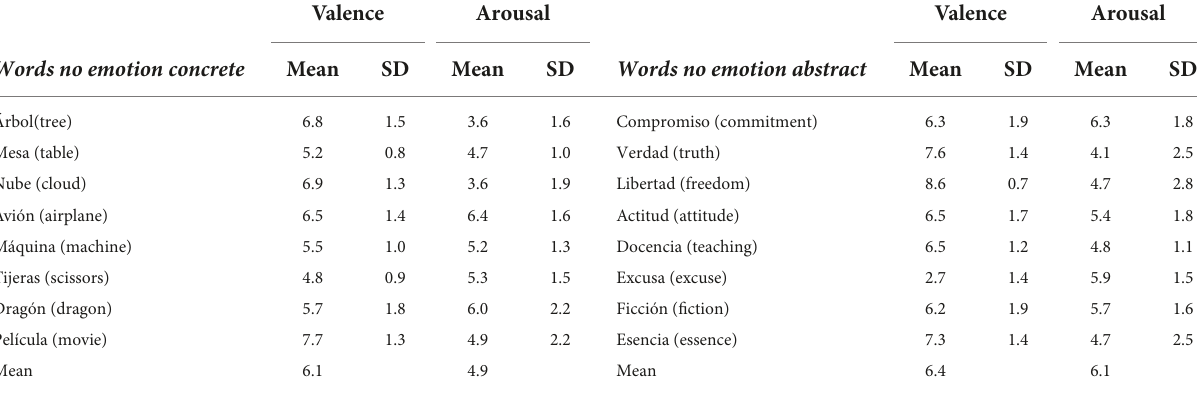
TABLE 3 Valencia and arousal norms provided by Stadthagen-Gonzalez et al. (2017) for words not referring to emotion used in the present study. Valence